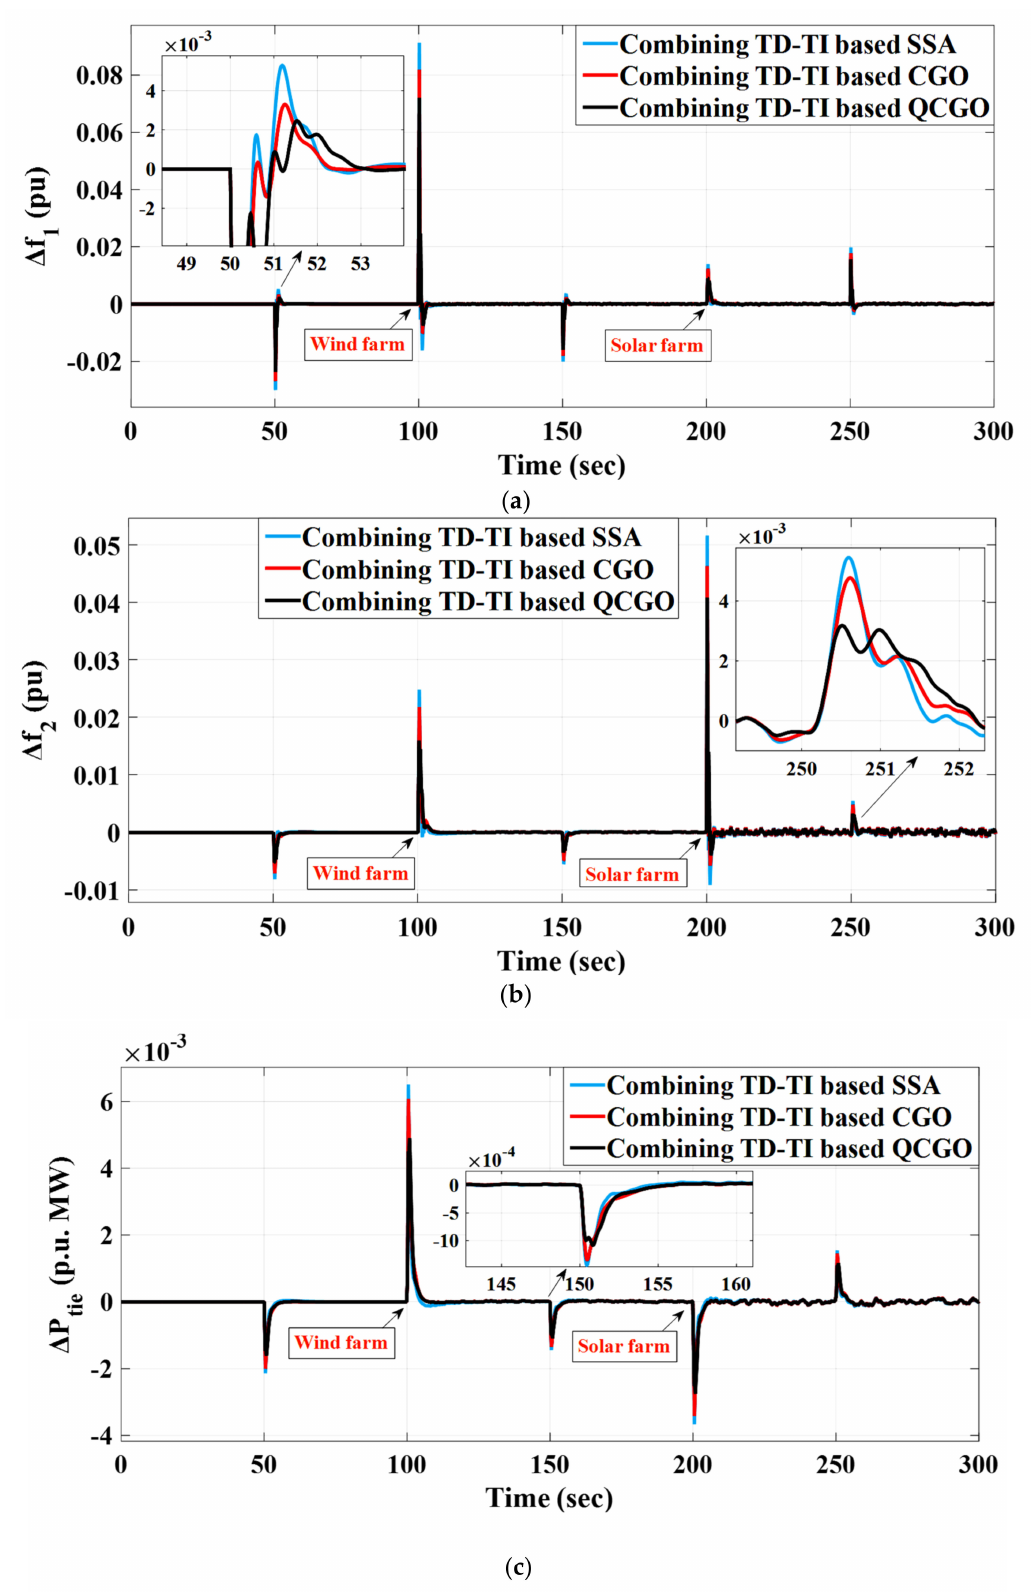
Figure 22. Dynamic power grid responses in case B.1: ( a ) ∆ f